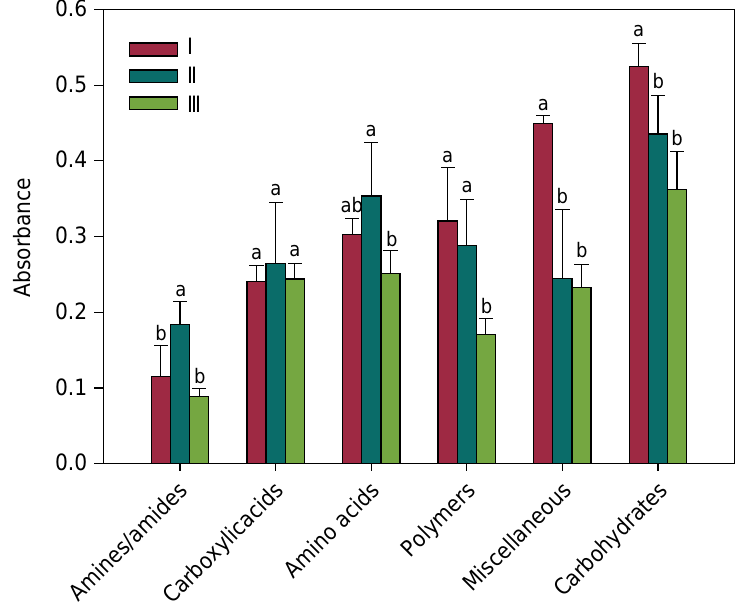
Figure 3. Relative use efficiency of soil microbial community on different carbon sources. Treatment: Ⅰ, control; Ⅱ, pre-emergence after sowing herbicide spraying; Ⅲ, post-emergence stem, and leaf herbicide spraying. Different letters indicate a significant difference at